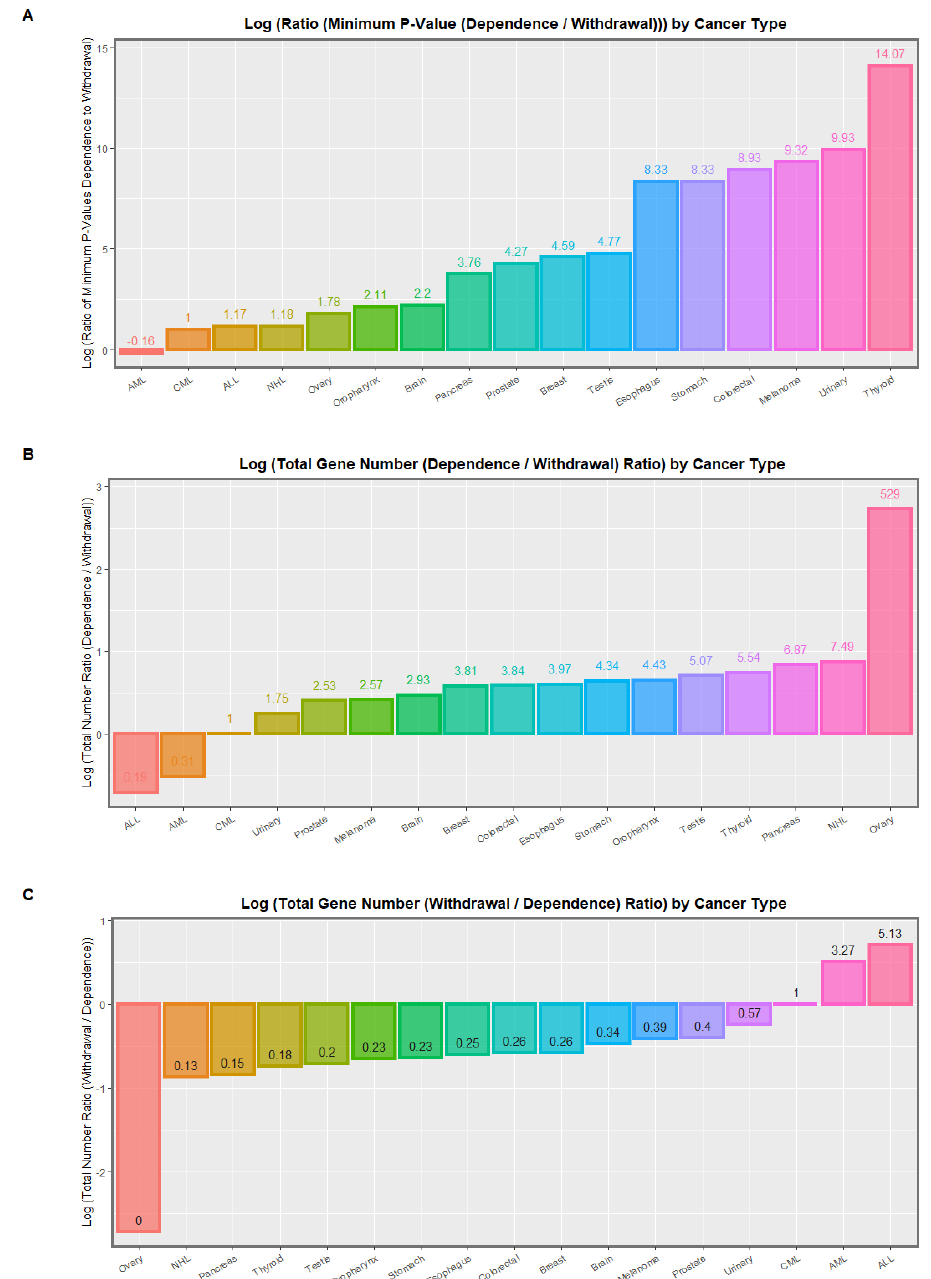
Figure 5. Log plots of significance levels for ( A ) ratio of p -values between cannabis dependence and withdrawal, ( B ) log of the dependence/withdrawal ratio of total gene numbers affected between cannabis dependence and withdrawal and ( C ) log of the withdrawal/dependence ratio of total gene numbers affected between cannabis dependence and withdrawal; each by tumor type from the Schrott EWAS data.